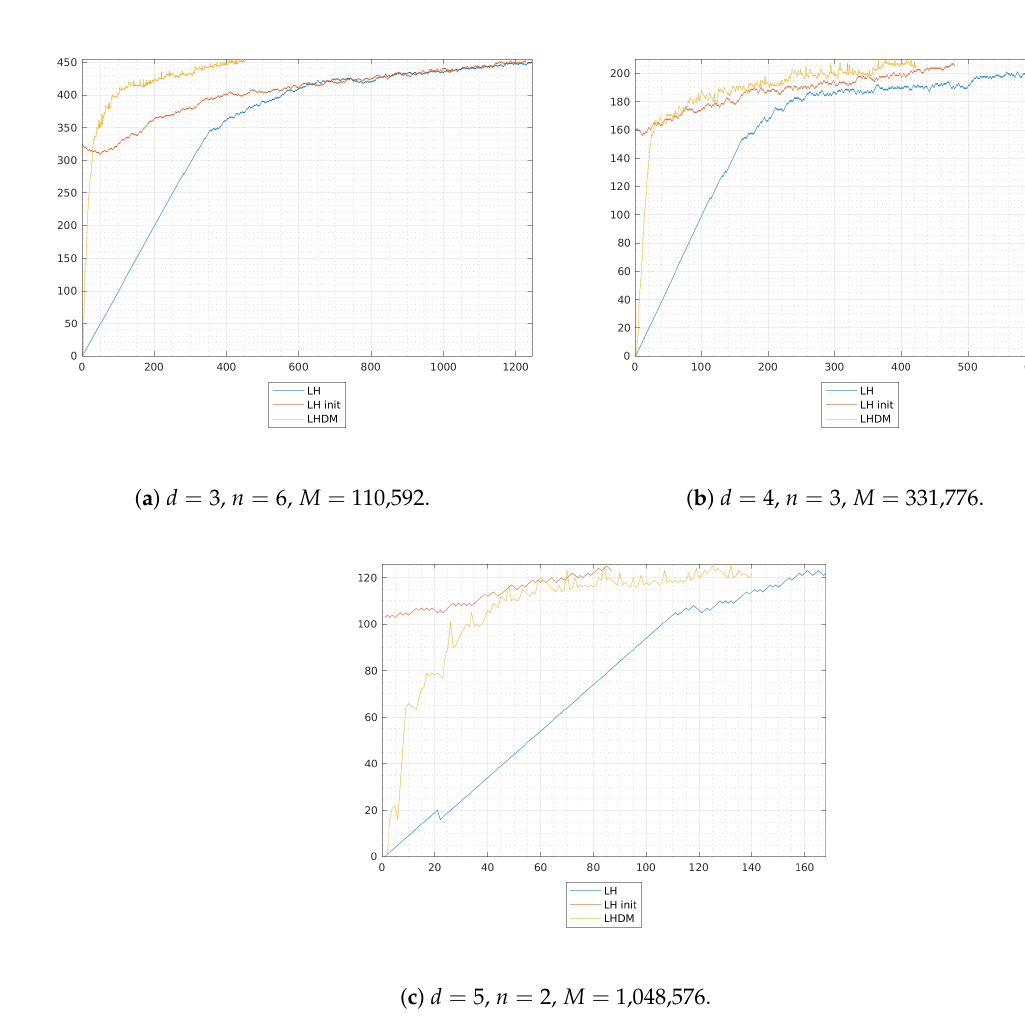
Figure 2. The evolution of the cardinality of the passive set P along the iterations of the three LH algorithms for Chebyshev nodes’